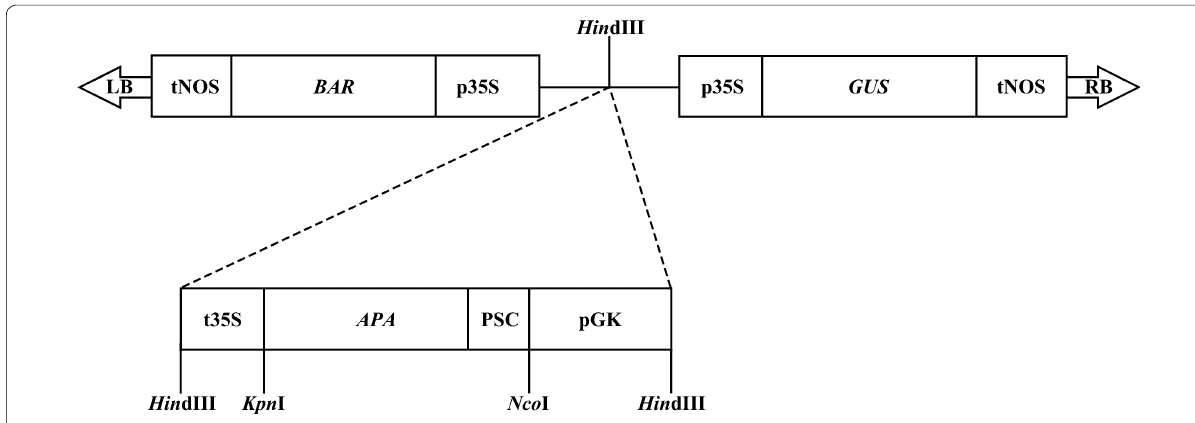
Fig. 1 Structure of the pCam-PSC-APA vector used for tobacco genetic transformation. The M. tuberculosis APA gene ( APA ) was fused with α-coixin signal peptide (PSC) under the control of γ-kafirin promoter (pGK) and the 35S terminator (t35S). The BAR and GUS genes are under the control of the 35S promoter (p35S) and the terminator from the NOS gene (tNOS). LB and RB are the borders of the expression